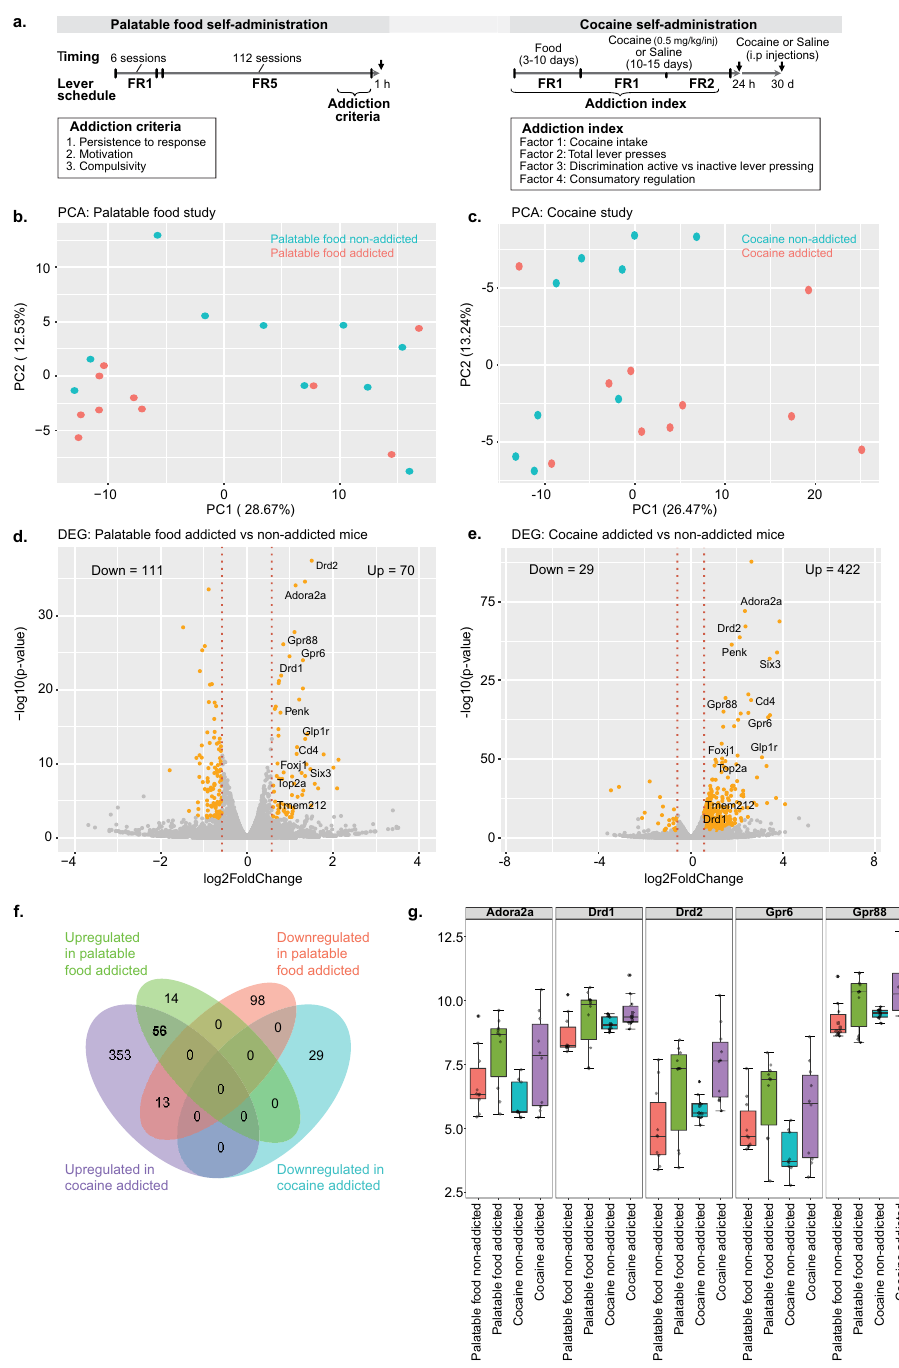
Figure 1. Gene expression pattern associated with food and cocaine addiction-like behaviors. ( a ) Experimental design of palatable food and cocaine self-administration studies. Black arrows indicates tissue collection in each study. ( b ) PCA plot explaining the transcriptome of palatable food non-addicted and addicted mice. ( c ) PCA plot analysis of the transcriptome of cocaine non-addicted and addicted mice. ( d ) Volcano plot of RNA- seq data representing the gene expression changes of significantly upregulated genes (70) and down-regulated genes (111) in mice addicted to palatable food as compared to mice non-addicted to palatable food. ( e ) Volcano plot of RNA-seq data representing the gene expression changes of significantly upregulated genes (422) and significantly down-regulated genes (29) in cocaine addicted mice as compared to cocaine non-addicted mice. ( f ) Venn diagram representing the overlap of differentially expressed genes from palatable food and cocaine studies. ( g ) Expression levels of Adora2a, Drd1, Drd2, Gpr6, and Gpr88 in palatable food and cocaine non-addicted and addicted